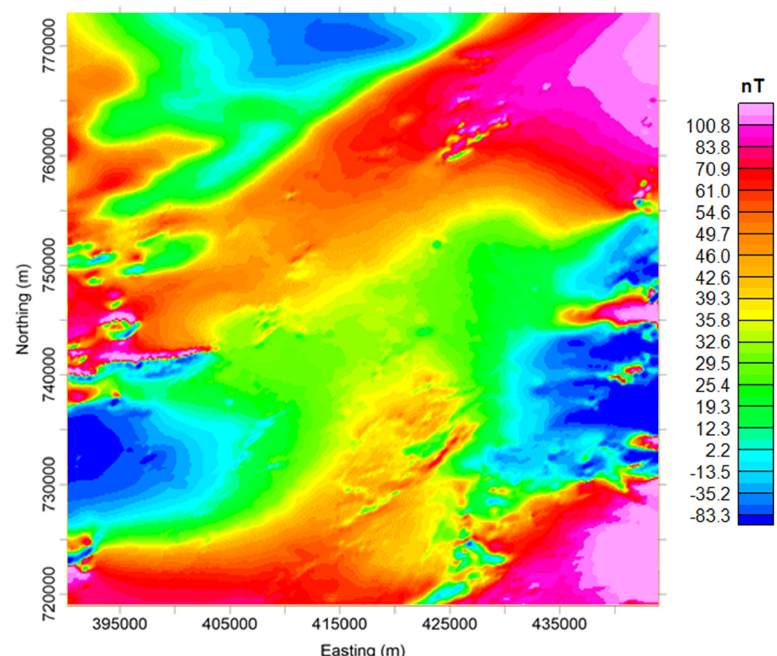
Minerals 2022 , 12 , x Figure 2. Total magnetic intensity data. Figure 2. Total magnetic intensity data.